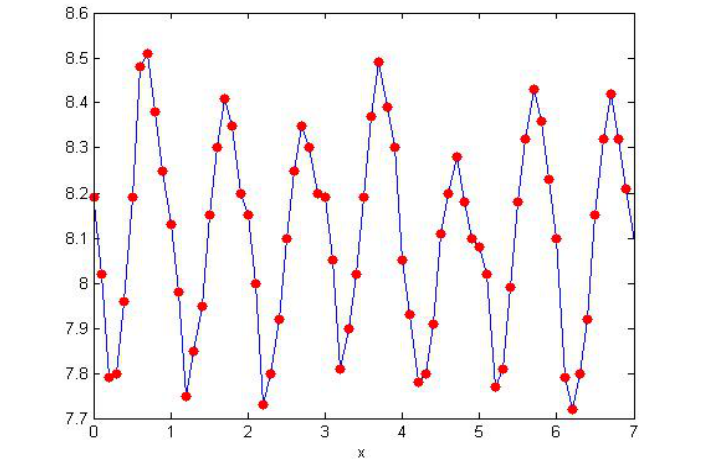
Figure 25. Curve of daily changing pH collected by artificial sampling.